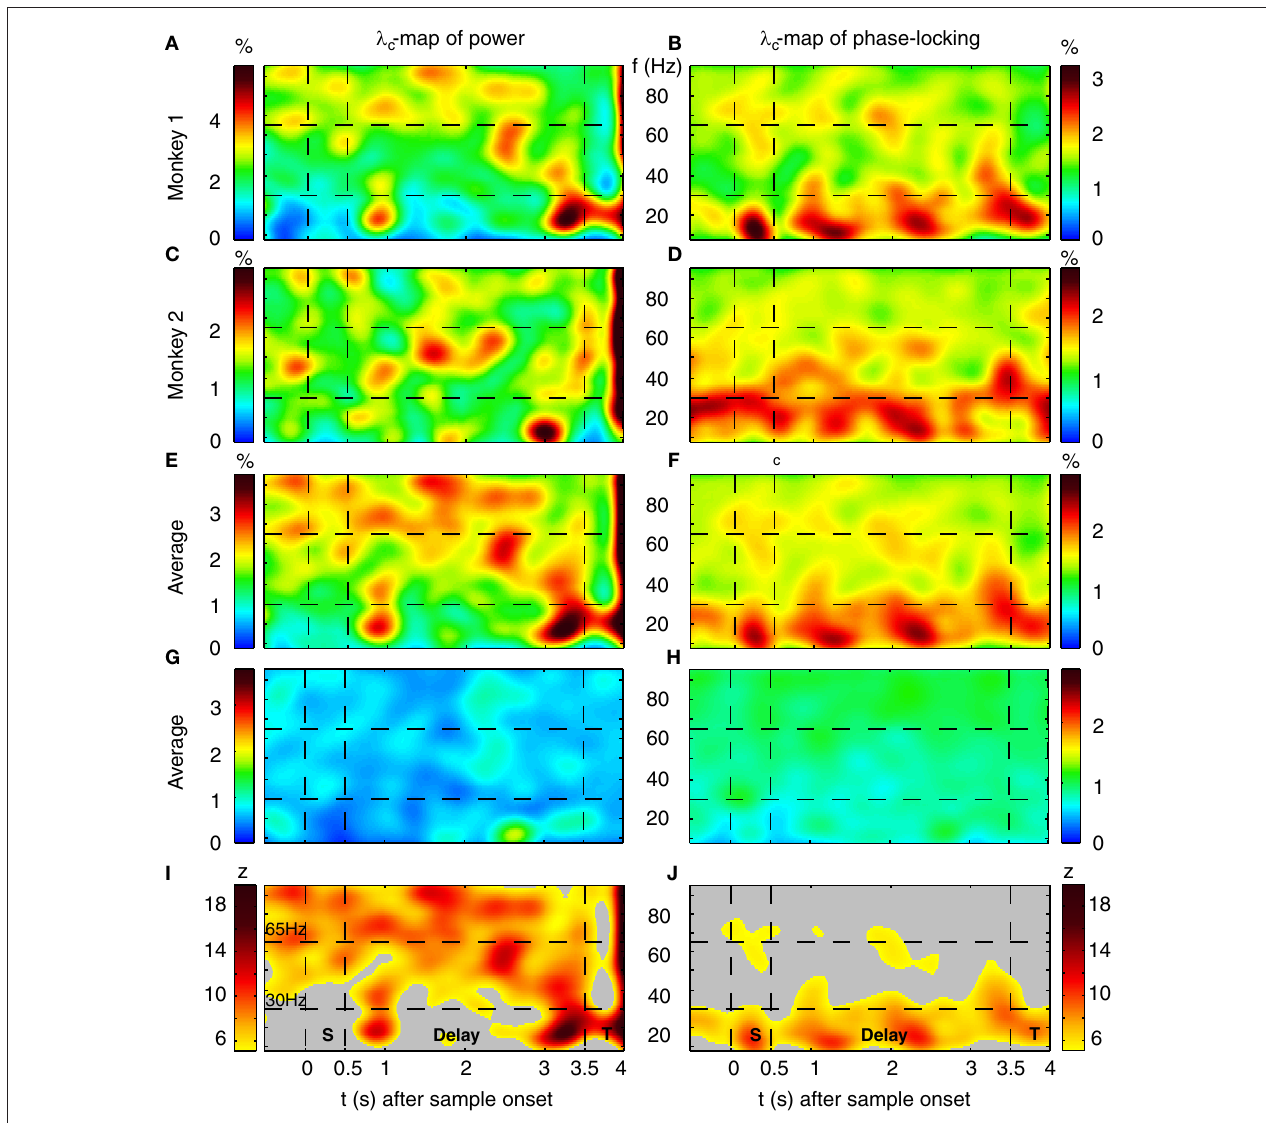
FIGURE 4 | Performance-dependent increases of β - and γ -oscillations and their phase-locking in prefrontal fi eld potentials. (A–F) Time-frequency λ c- maps for individual monkeys (A–D) and as average across subjects (E,F) provide the percentage of sites/pairs with signifi cant increases of power/phase-locking in trials with correct responses, based on 12 sessions, 4124 trials, 152 sites and 921 pairs of sites. Abscissa and ordinate represent peri-stimulus time aligned to the onset of sample stimuli and signal frequency, respectively. Color-codes provide the percentage of sites/pairs with signifi cant changes (‘ S ’, ‘ T ’: Sample and Test stimulus presentation, ‘Delay’: during delay the information of the sample has to be maintained). The left column provides maps for power and the